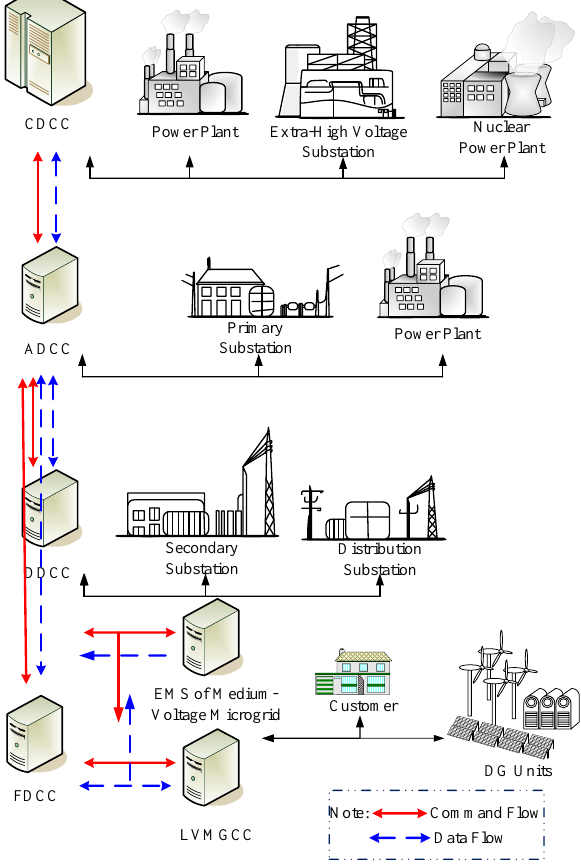
Figure 2. Hierarchical dispatch and control system (HDCS). CDCC: central dispatch and control center; ADCC: area dispatch and control center; DDCC: distribution dispatch and control center; FDCC: feeder dispatch control center; EMS: energy management system; LVMGCC: low-voltage microgrid control center; and DG: distributed generation.